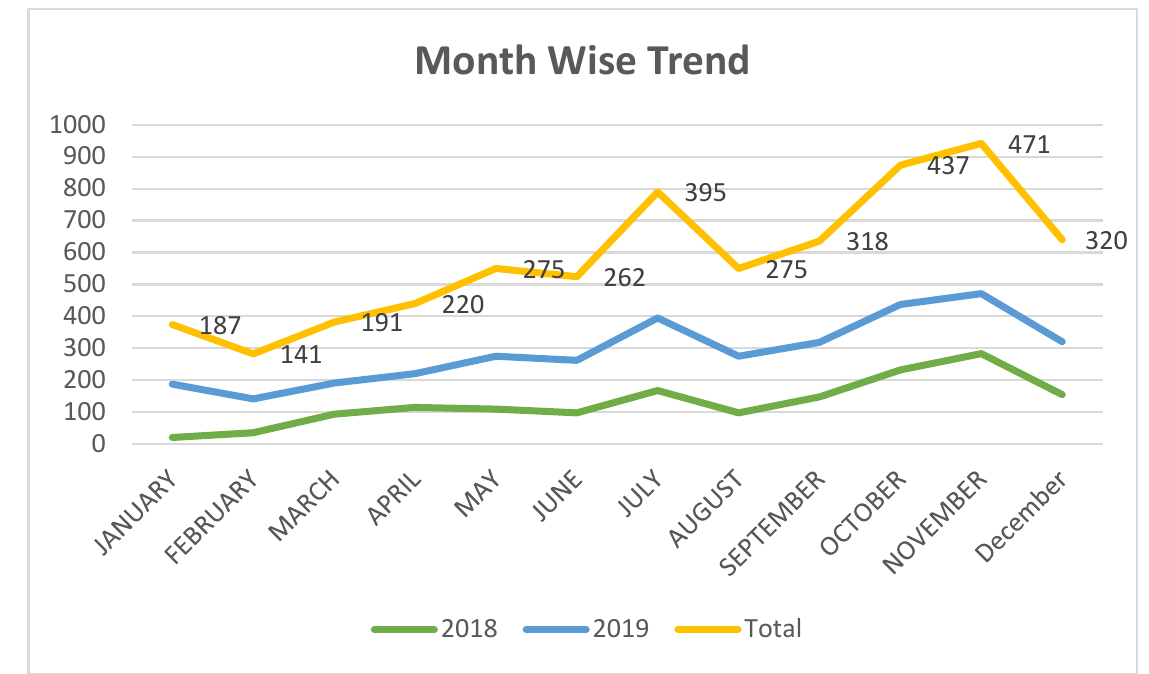
Figure 6. The year versus month-wise trend of women visiting for sonomammography.